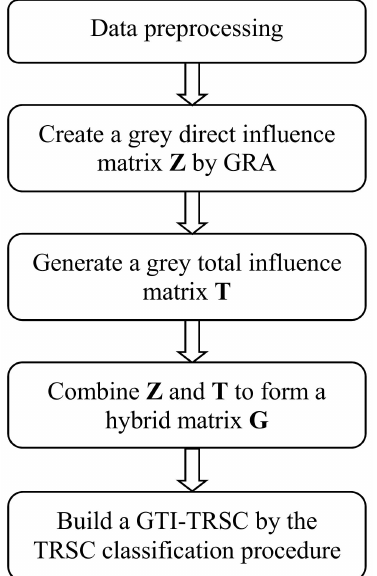
Figure 1. A flowchart for constructing the proposed classifier (GRA: Grey Relational Analysis, GTI-TRS: grey-total-influence-based tolerance rough